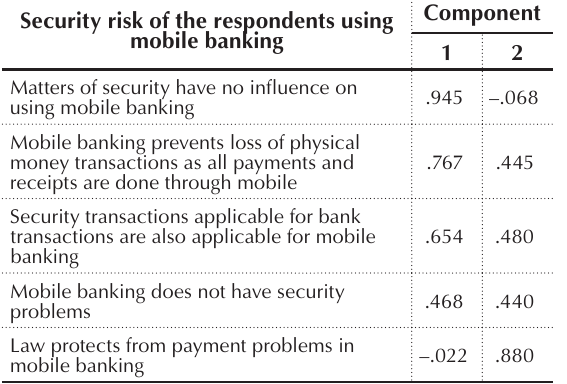
Table 7. (cid:38)(cid:258)(cid:272)(cid:410)(cid:381)(cid:396)(cid:3)(cid:258)(cid:374)(cid:258)(cid:367)(cid:455)(cid:400)(cid:349)(cid:400)(cid:3)(cid:381)(cid:374)(cid:3)(cid:410)(cid:346)(cid:286)(cid:3)(cid:393)(cid:396)(cid:349)(cid:448)(cid:258)(cid:272)(cid:455)(cid:3)(cid:396)(cid:349)(cid:400)(cid:364)(cid:3)(cid:3)